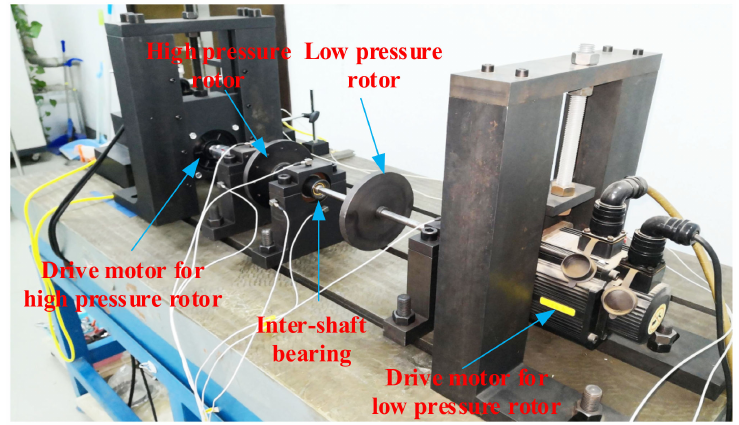
Figure 9. Fault simulation system of inter-shaft bearing. A NU202EM model from NSK Company (Shenyang, China) was used as an experi- mental bearing in this paper. Rectangular defects are artificially implanted on the rings and rolling surface of the inter-shaft bearing by the wire-cutting method. The width and depth of the defects on the surface of the IR and OR are 0.5 mm. The width and depth of the defects on the surface of the rollers are 0.1 mm, and the same defects run through the entire cylindrical roller longitudinally. A defective inter-shaft bearing is shown in Figure 10.